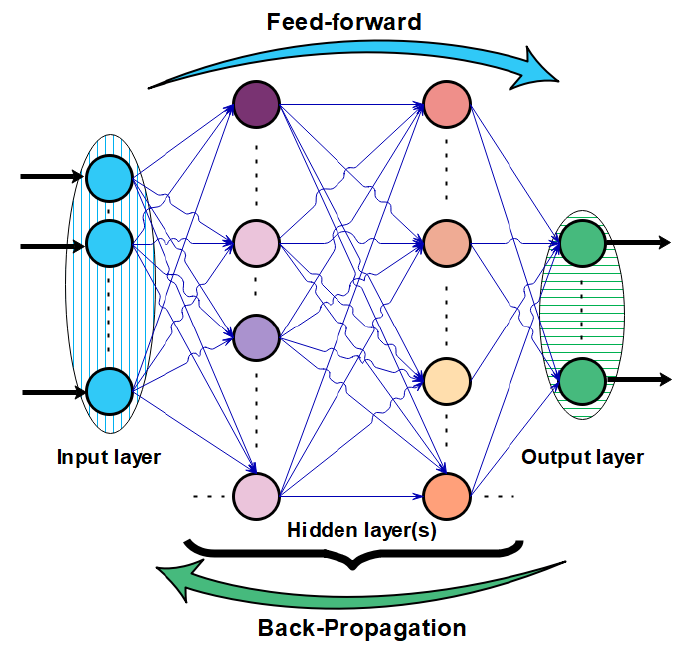
Figure 3. Architecture of applied neural network and learning process principle.